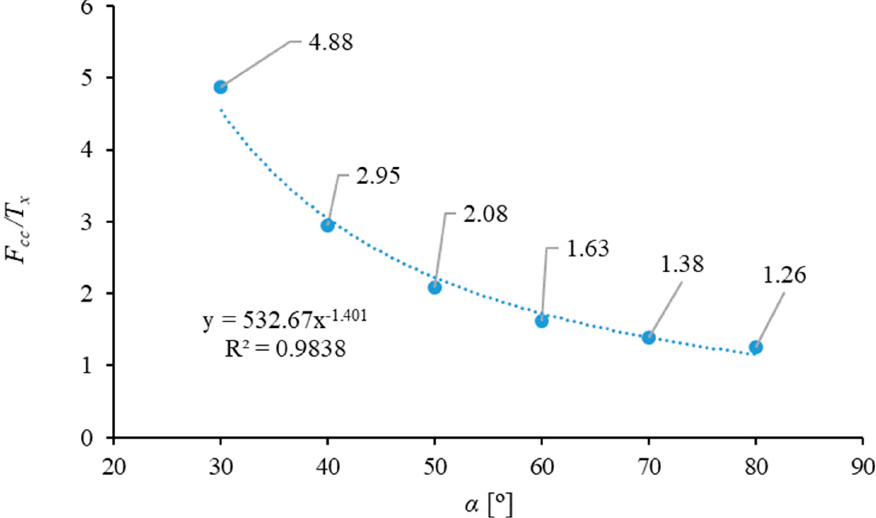
Figure 12. Characteristic curve representing the variance of the ratio of forces F cc /T x .